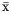
The most significant activity and inactivity structural features occurring in the Rational-final model.(A) Structural features alerting for activity in the Rational-final model. (B) Structural features alerting for inactivity in the Rational-final model. The selection of activity features was based on a ranking by the formula |0.2 - x¯|∙ χ2, where x¯ is the mean activity of all training set structures containing the feature. The selection of inactivity features was done by significance (χ2) among the ‘pure’ inactivity features, i.e. only appearing in inactive substances. In both cases χ2 denotes Chi-square independence test with one degree of freedom with Yates’ correction.